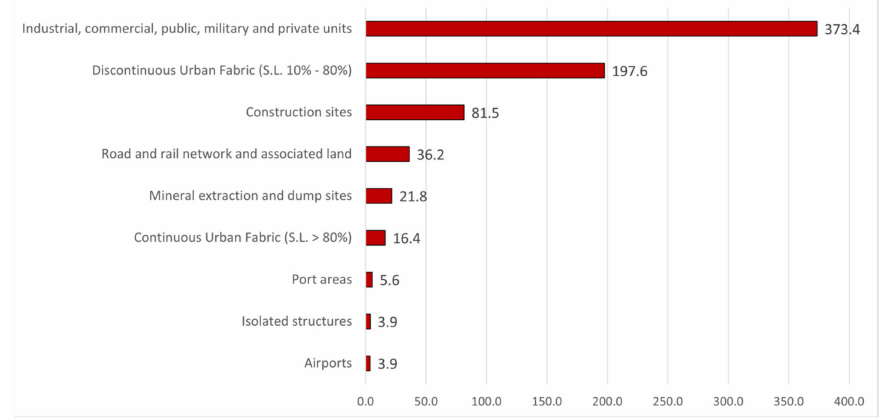
Figure 8. Estimated loss of water holding capacity in Functional Urban Areas by land use because of sealing during 2012–2008 (mio m 3